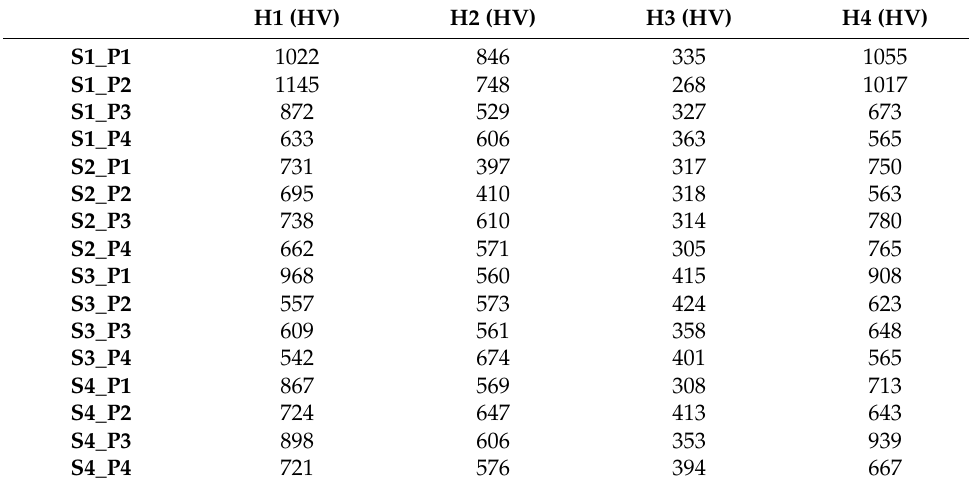
Table 4. Microhardness at different positions